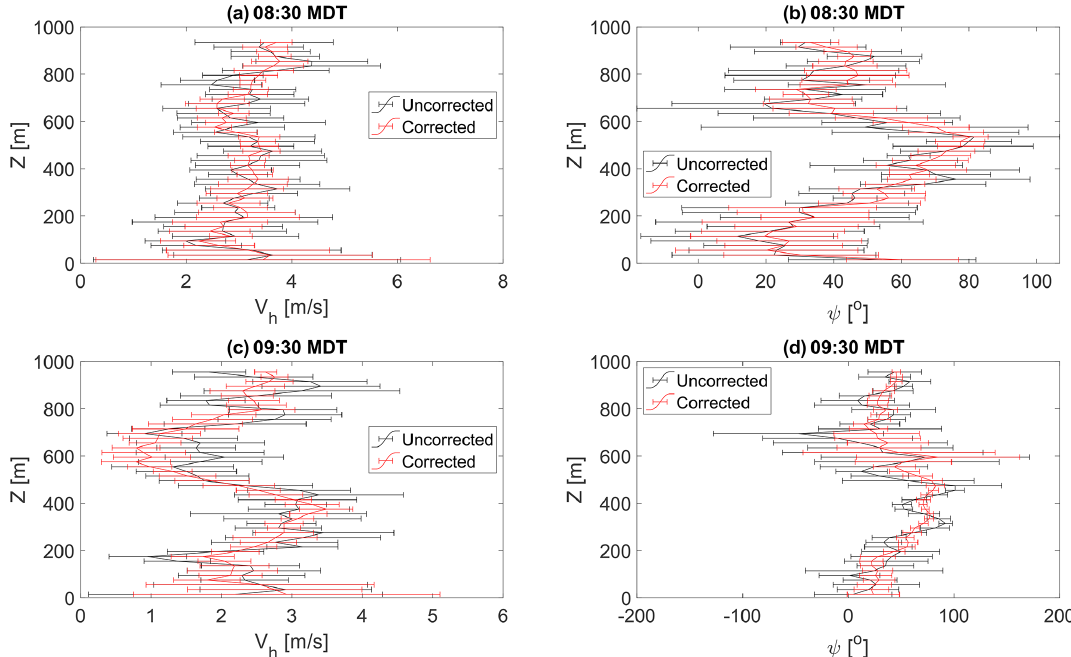
Figure 6. Comparison of mean (a) horizontal wind magnitude and (b) wind direction profiles measured by sUAS 1 at 08:30MDT with and without correction applied. Horizontal mean magnitude and direction profiles measured at 09:30MDT are shown in (c, d) , respectively.